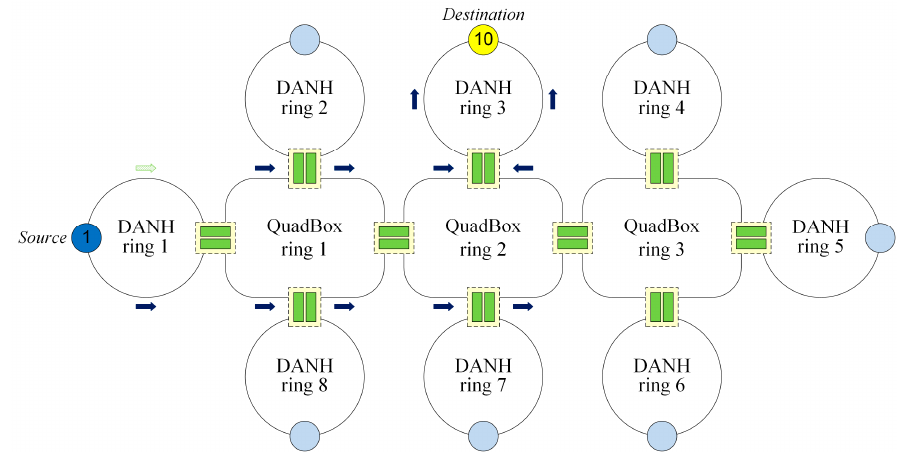
Figure 7. Forwarding a unicast frame using the filtering HSR traffic (FHT) technique.